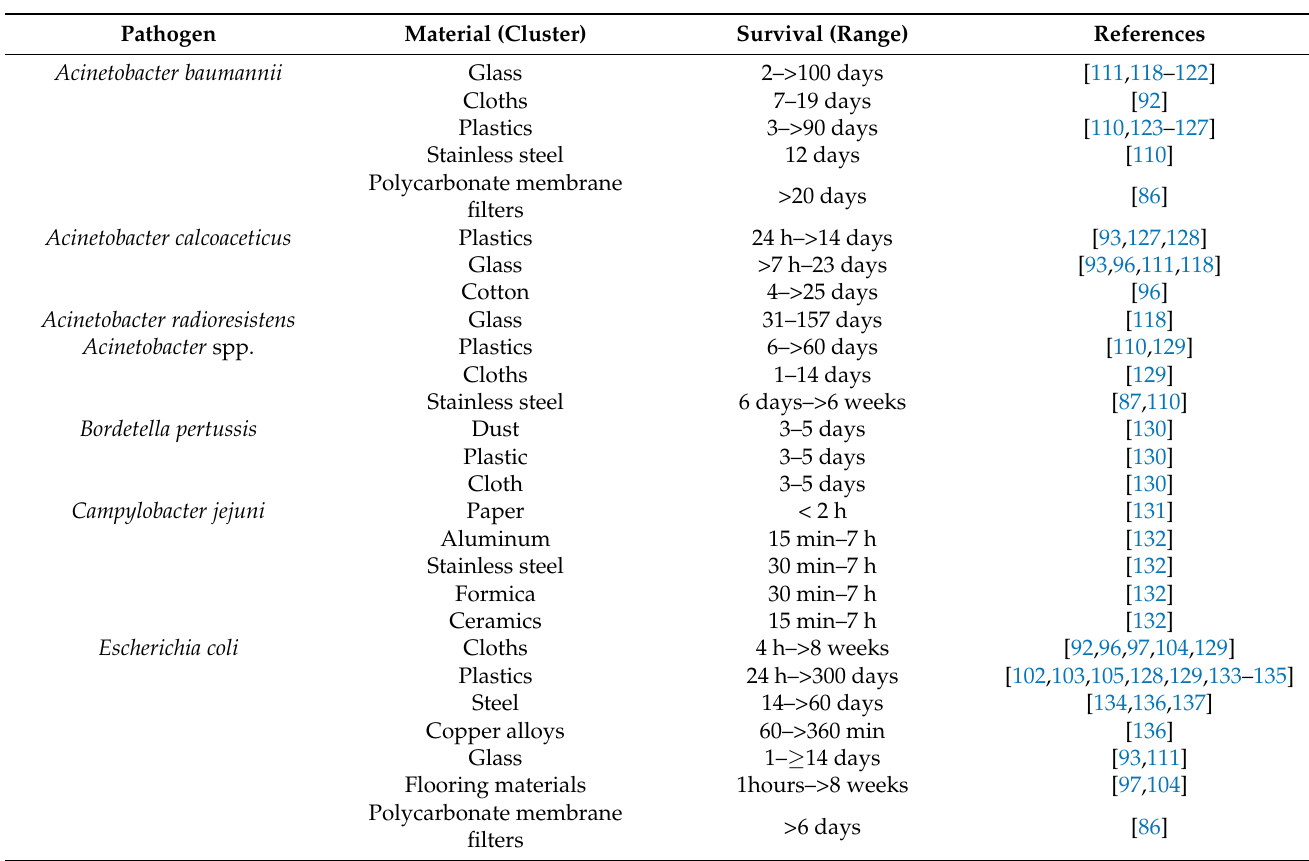
Table 4. Survival of gram-negative